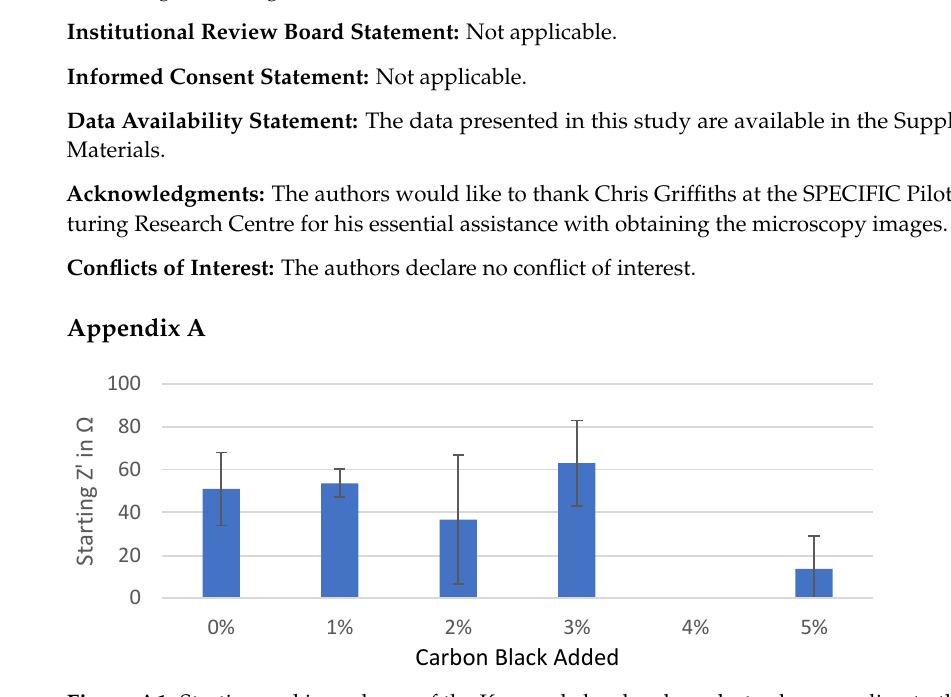
Figure A1. Starting real impedance of the Kuranode hard carbon electrodes according to the conductive additive content, as measured with the electrolyte containing PC as a low-viscosity solvent.